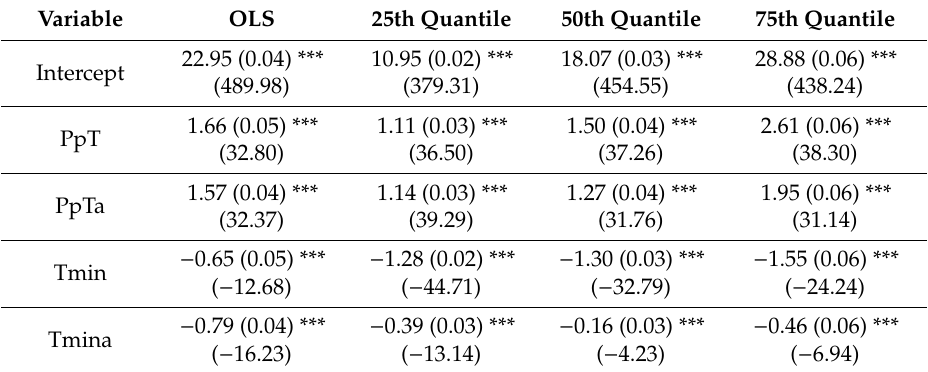
Figure 5. Quantile regression results for the full model of predicted abundance (response) across different abundance quantiles. Plots show the estimated coefficients of each covariate considering the total precipitation (PpT) and minimum temperature (Tmin), and their anomalies (PpTa and Tmina, respectively). The quantiles vary from 0.05 to 0.95. Shaded area indicates bootstrapped 95% confidence intervals for each of the ‘quantreg’ estimates. The horizontal lines represent the OLS estimate where the dotted red lines are the 95% confidence interval for linear regression. Table 2. Quantile regression coe ffi cients (and standard error) at di ff erent